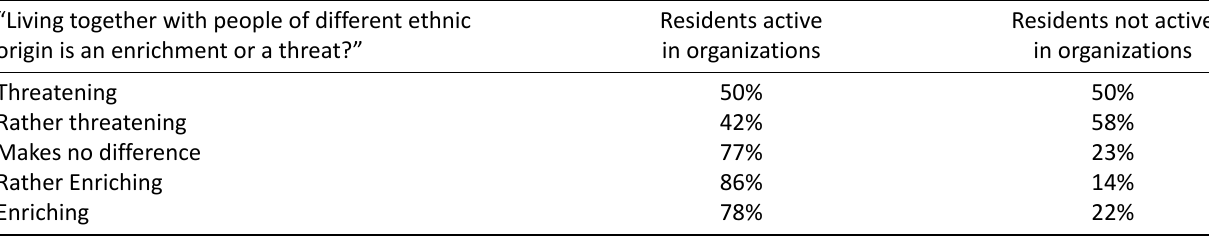
Table 2. People of Dutch descent between 18 and 35 years of age in Amsterdam neighbourhoods: Being active in organi- zations and their attitude towards ethnic